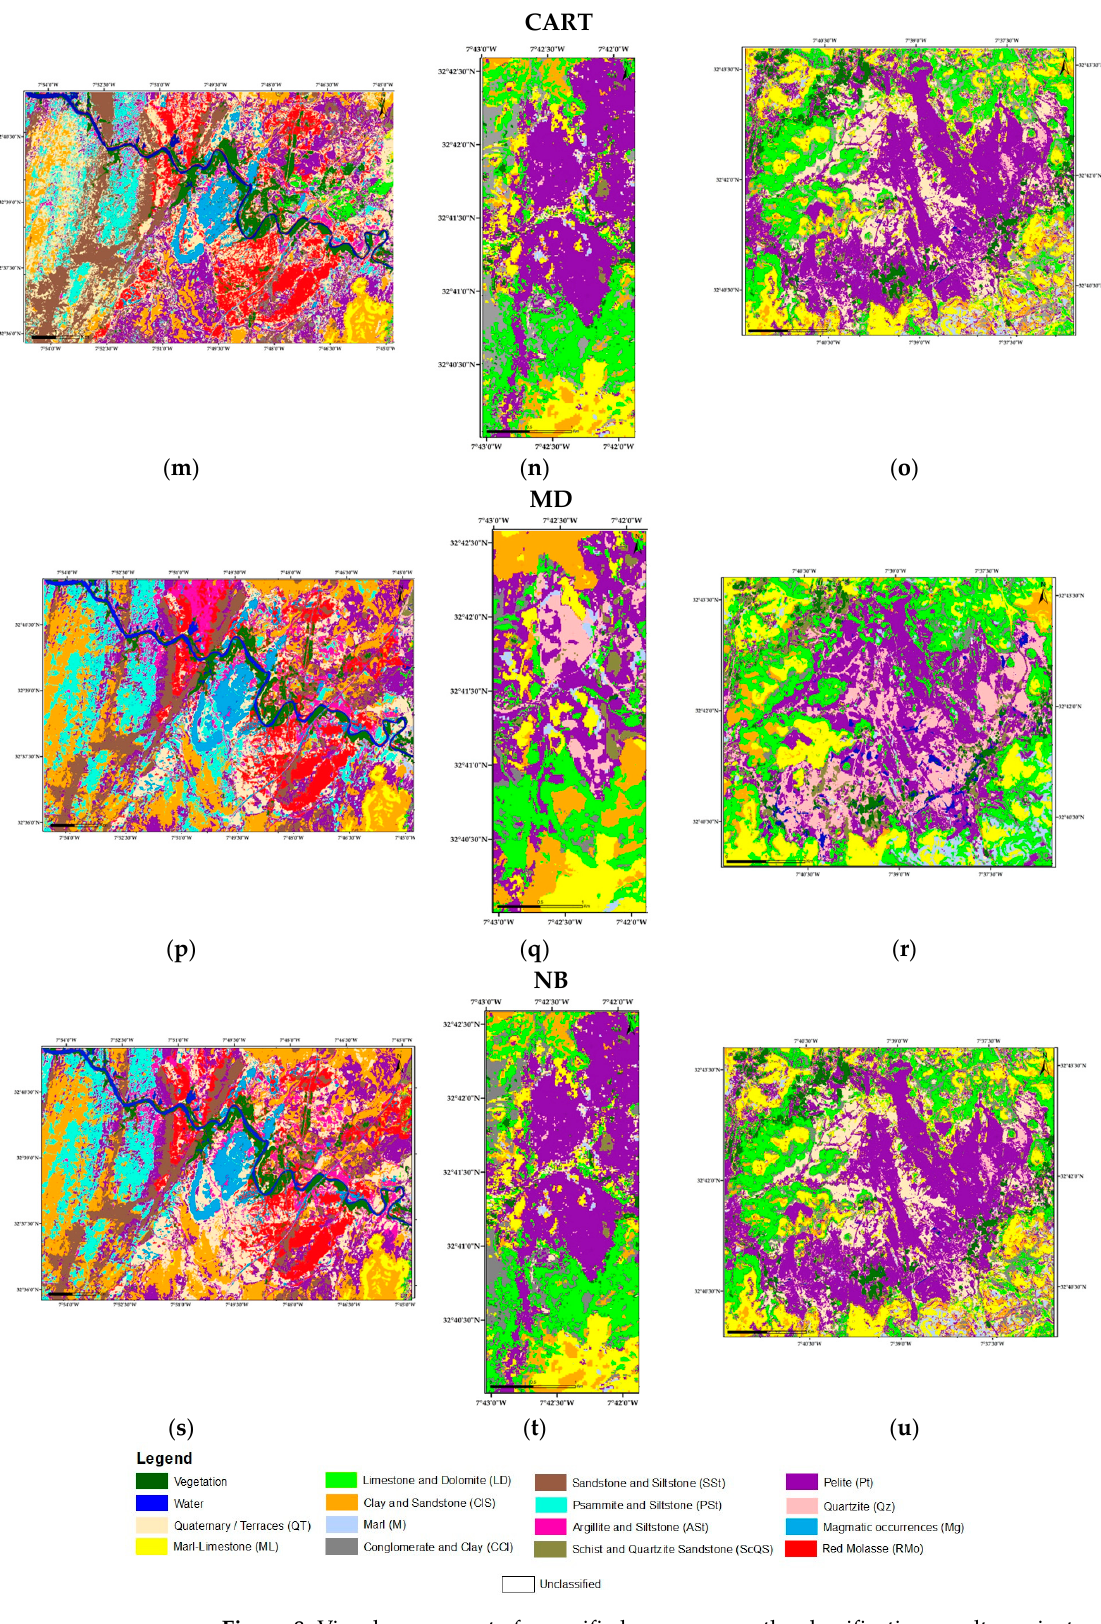
Figure 8. Visual assessment of magnified areas among the classification results against an enhanced color composite and existing geological